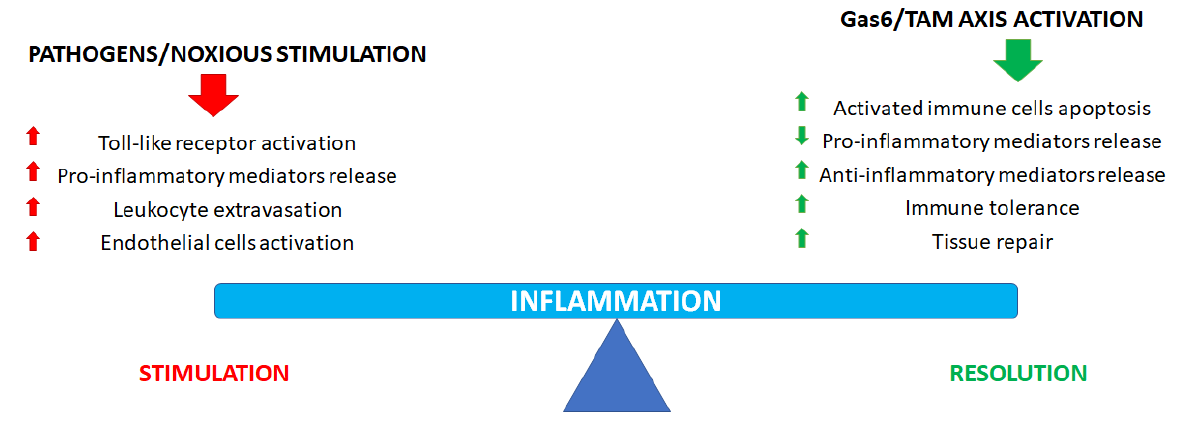
Figure 1. Role of the Gas6/TAM axis in inflammatory process regulation and resolution.